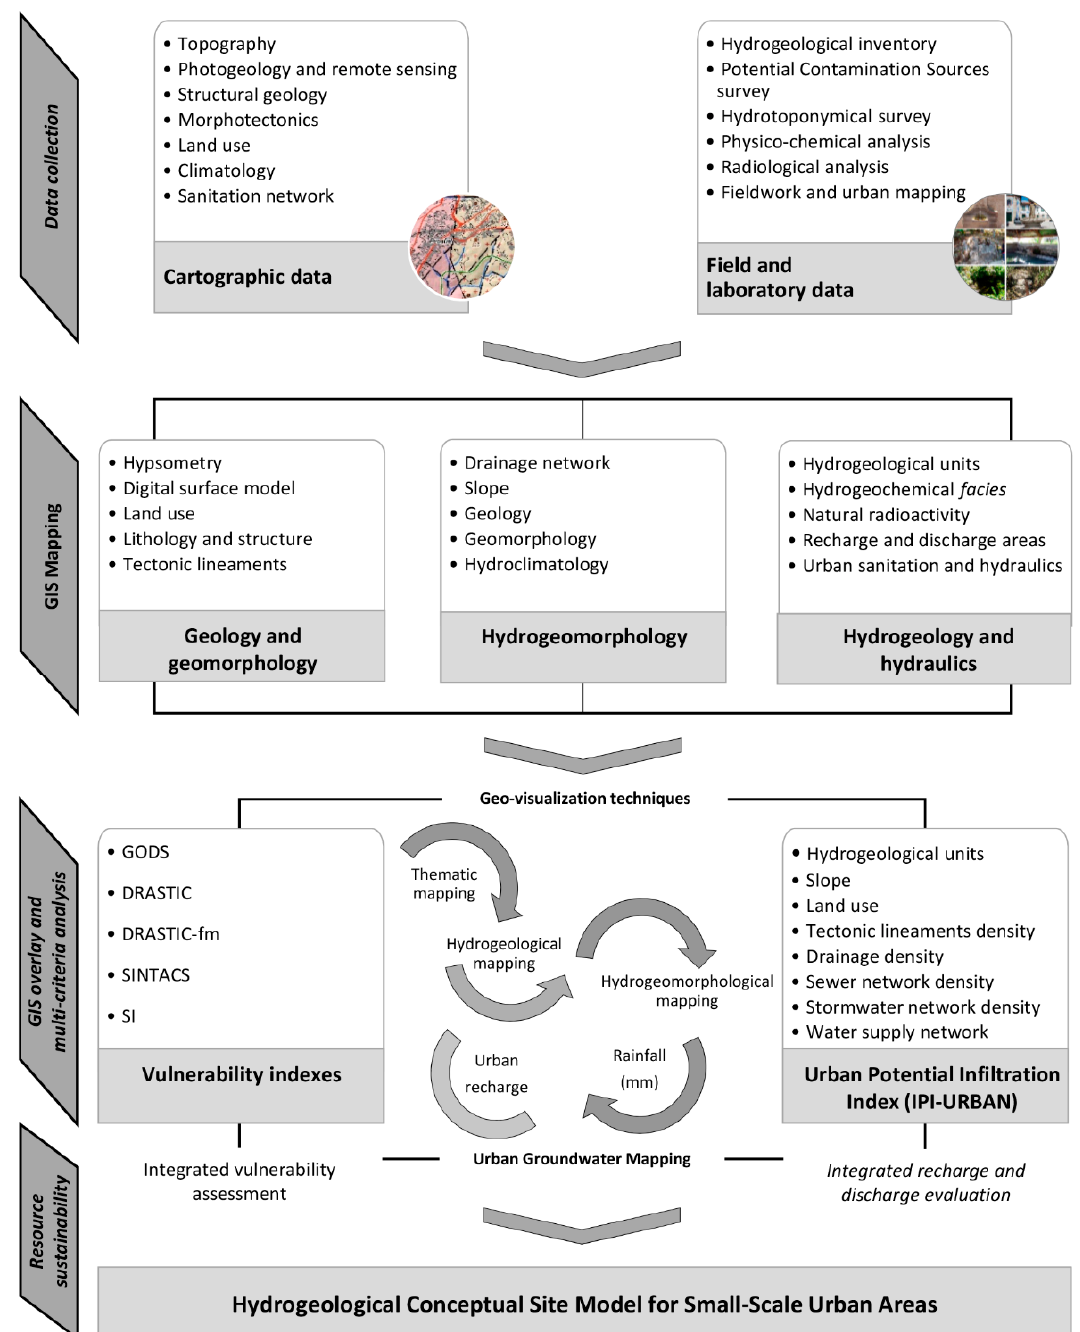
Figure 1. Conceptual flowchart overview for the urban groundwater studies of small-scale urban areas, namely Penafiel municipality (NW Portugal).